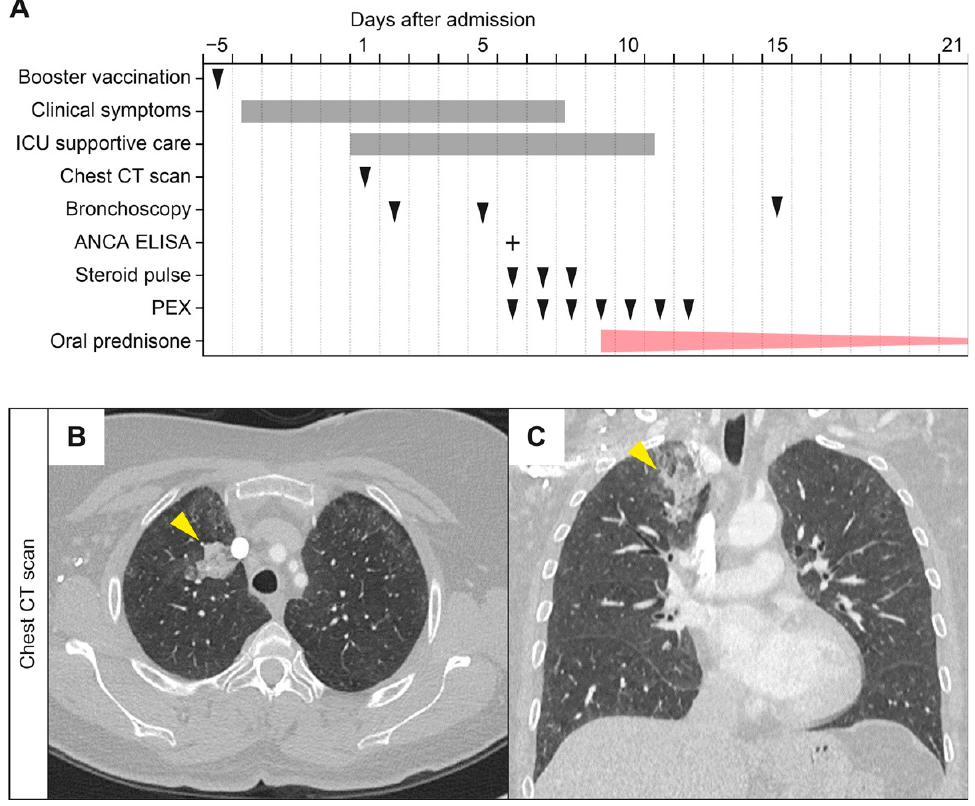
Figure 1. Time course of the case and radiographic findings. ( A ) Time course of booster vaccination, admission, performance of bronchoscopy, chest CT scan, and treatment regimen. ( B , C ) Computed tomography of the chest at the time of admission in axial and coronal reformation. At the time of admission, a CT scan confirmed a focal pulmonary hemorrhage in the right upper lobe with focal consolidation (arrowheads) and surrounding ground glass opacities. Furthermore, CT scans revealed subtle ground glass opacities in the anterior upper lobes. Abbreviations: ANCA = antineutrophil cytoplasmic antibody; CT = computed tomography, ELISA = enzyme-linked immunosorbent assay; ICU = intensive care unit; PEX = plasma exchange. Table 1. Key laboratory parameters at admission.